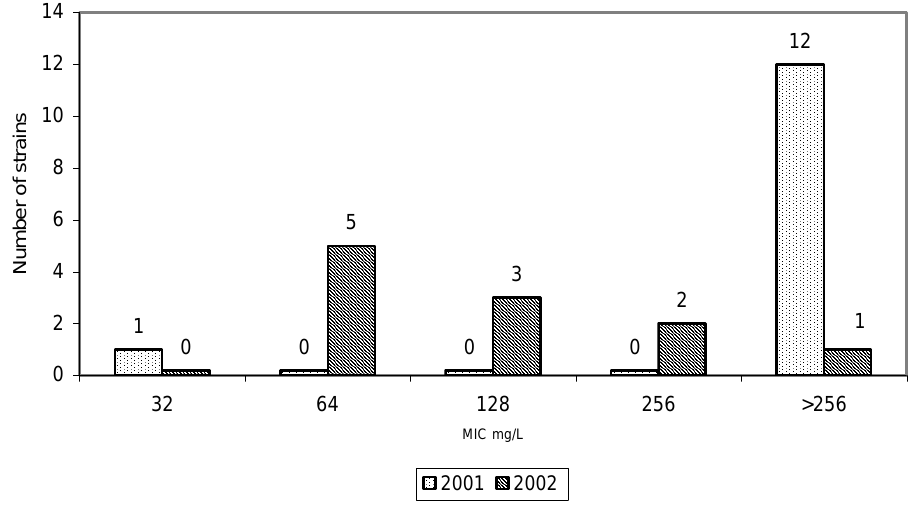
Figure 10. Distribution of the vancomycin MICs of the vanA positive E. durans strains isolated in